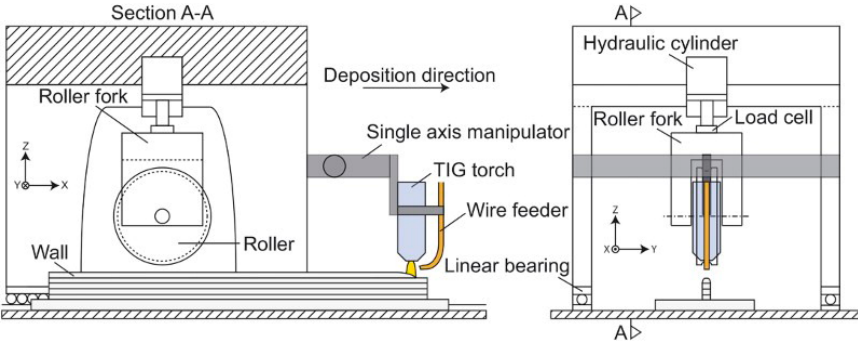
Figure 2. Schematic diagram of rolling and welding equipment [21].